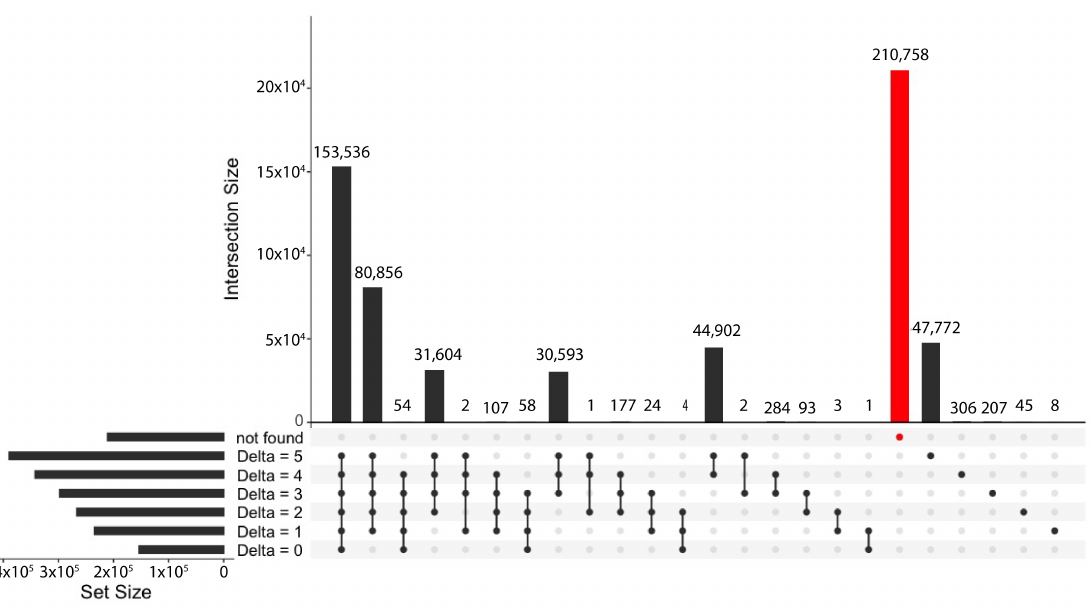
Figure 12. Numberofminimalbit-lengthsolutionsfoundbythemulti-parameterheuristic, astheparameter ∆ varies. For 35% of the tested batches, the heuristic was not able to find the optimal